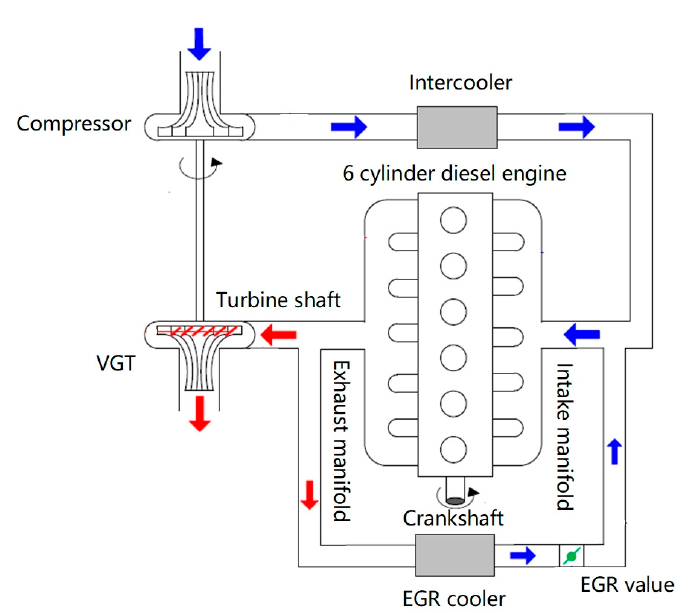
Figure 3. VGT-equipped diesel engine with an exhaust gas recirculation (EGR) system.